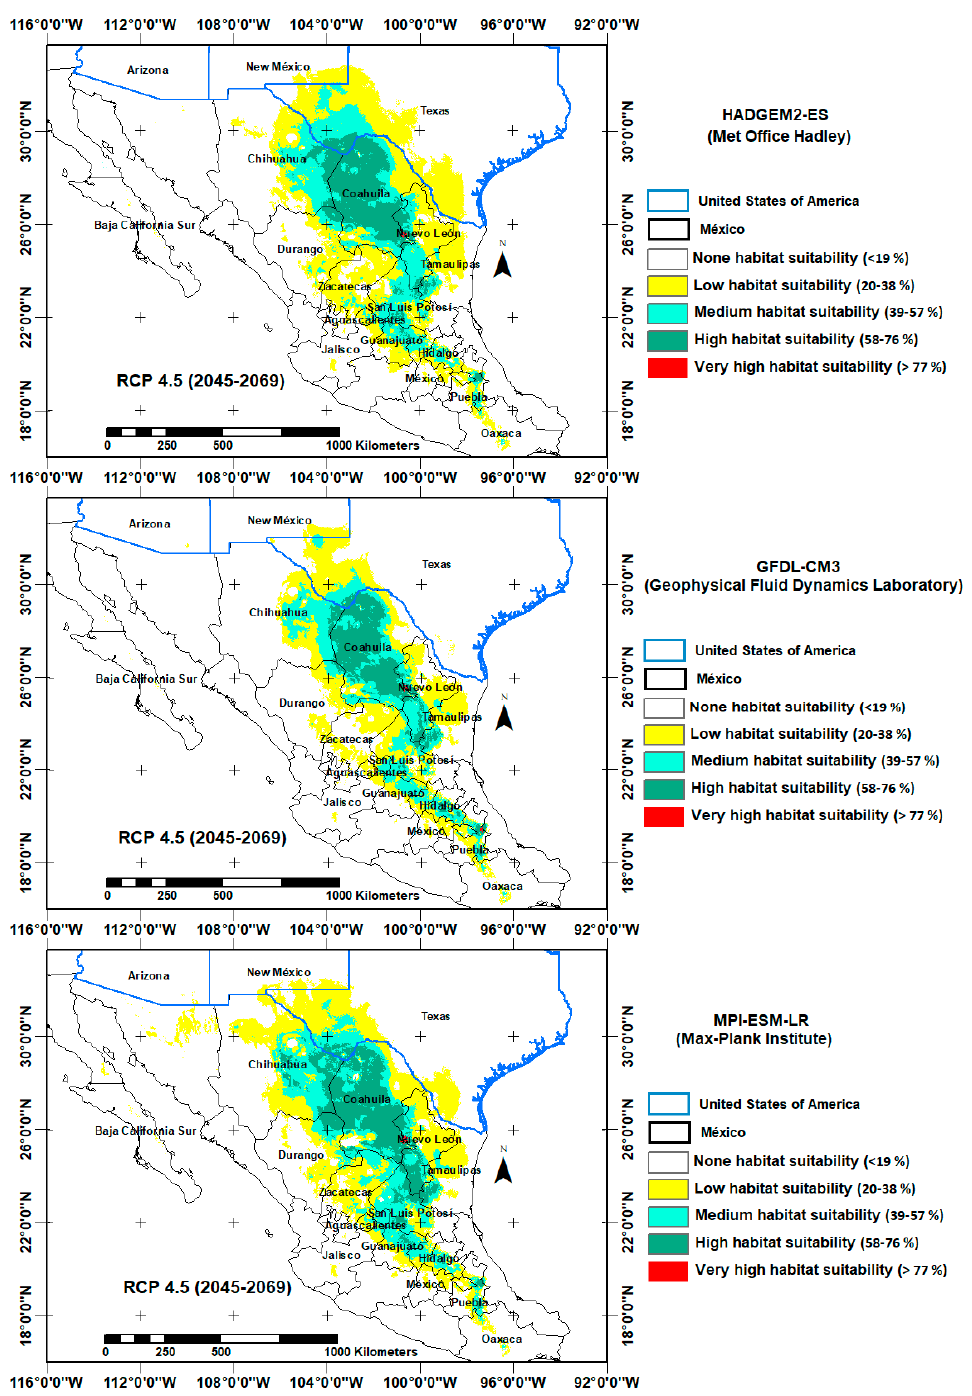
Figure 5. Candelilla’s potential distribution areas with a representative concentration pathway (RCP) of 4.5, under three global climate models (GCMs) for Mexico and the USA.